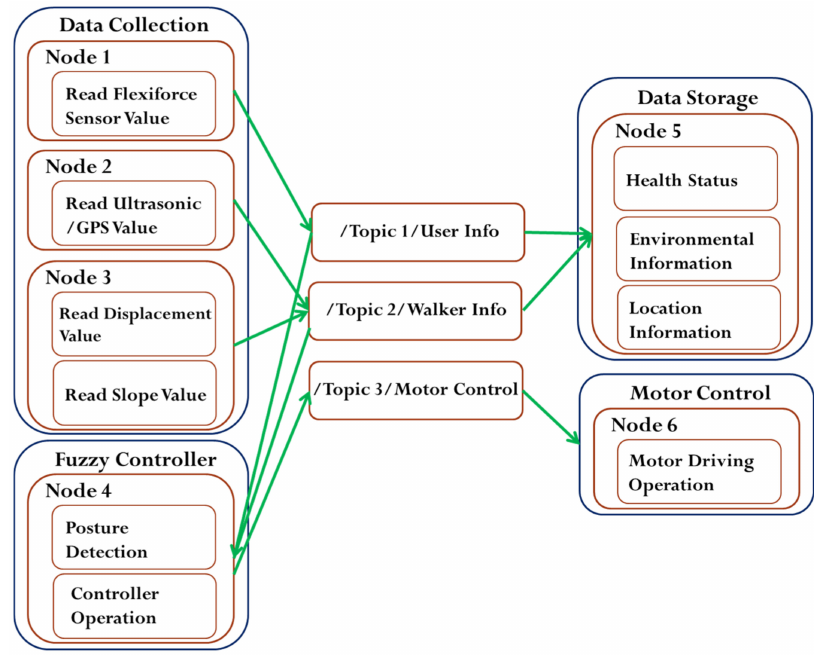
Figure 5. Robot operating system (ROS) framework of smart